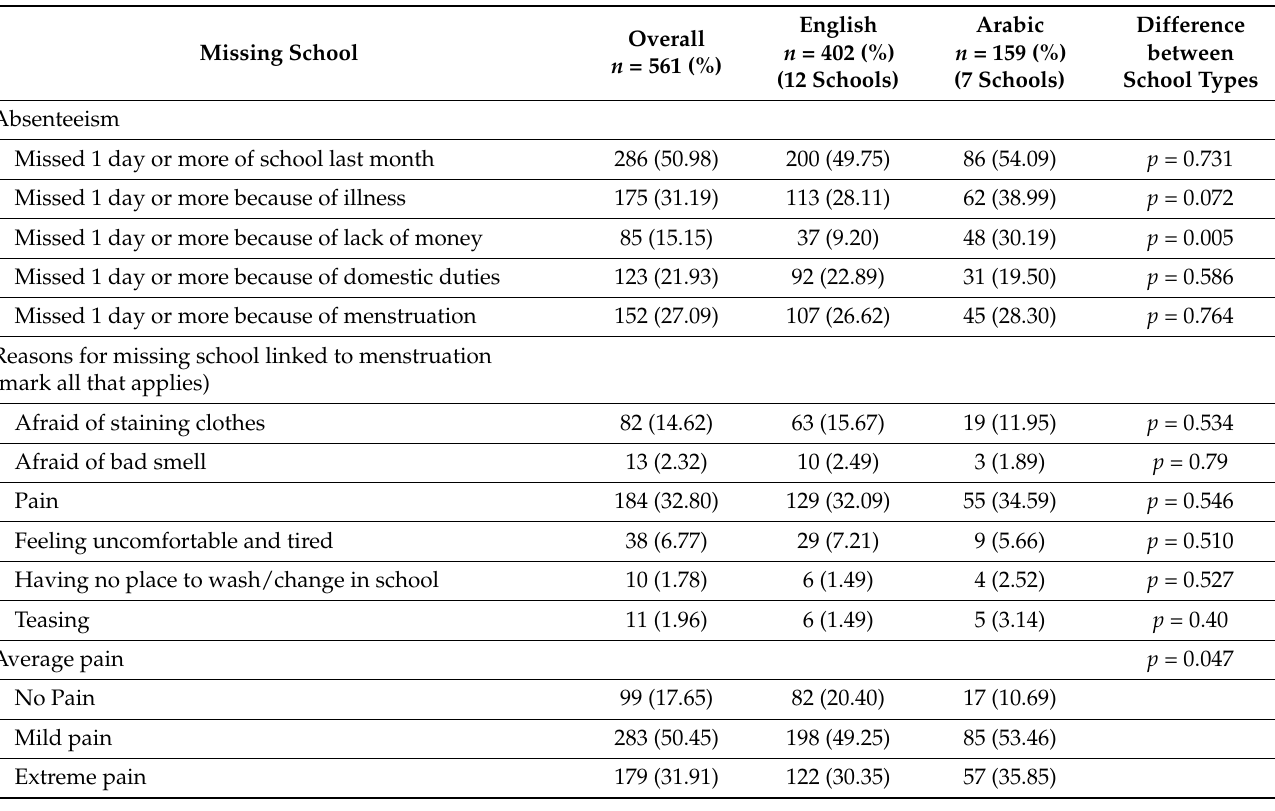
Table 5. Missing School